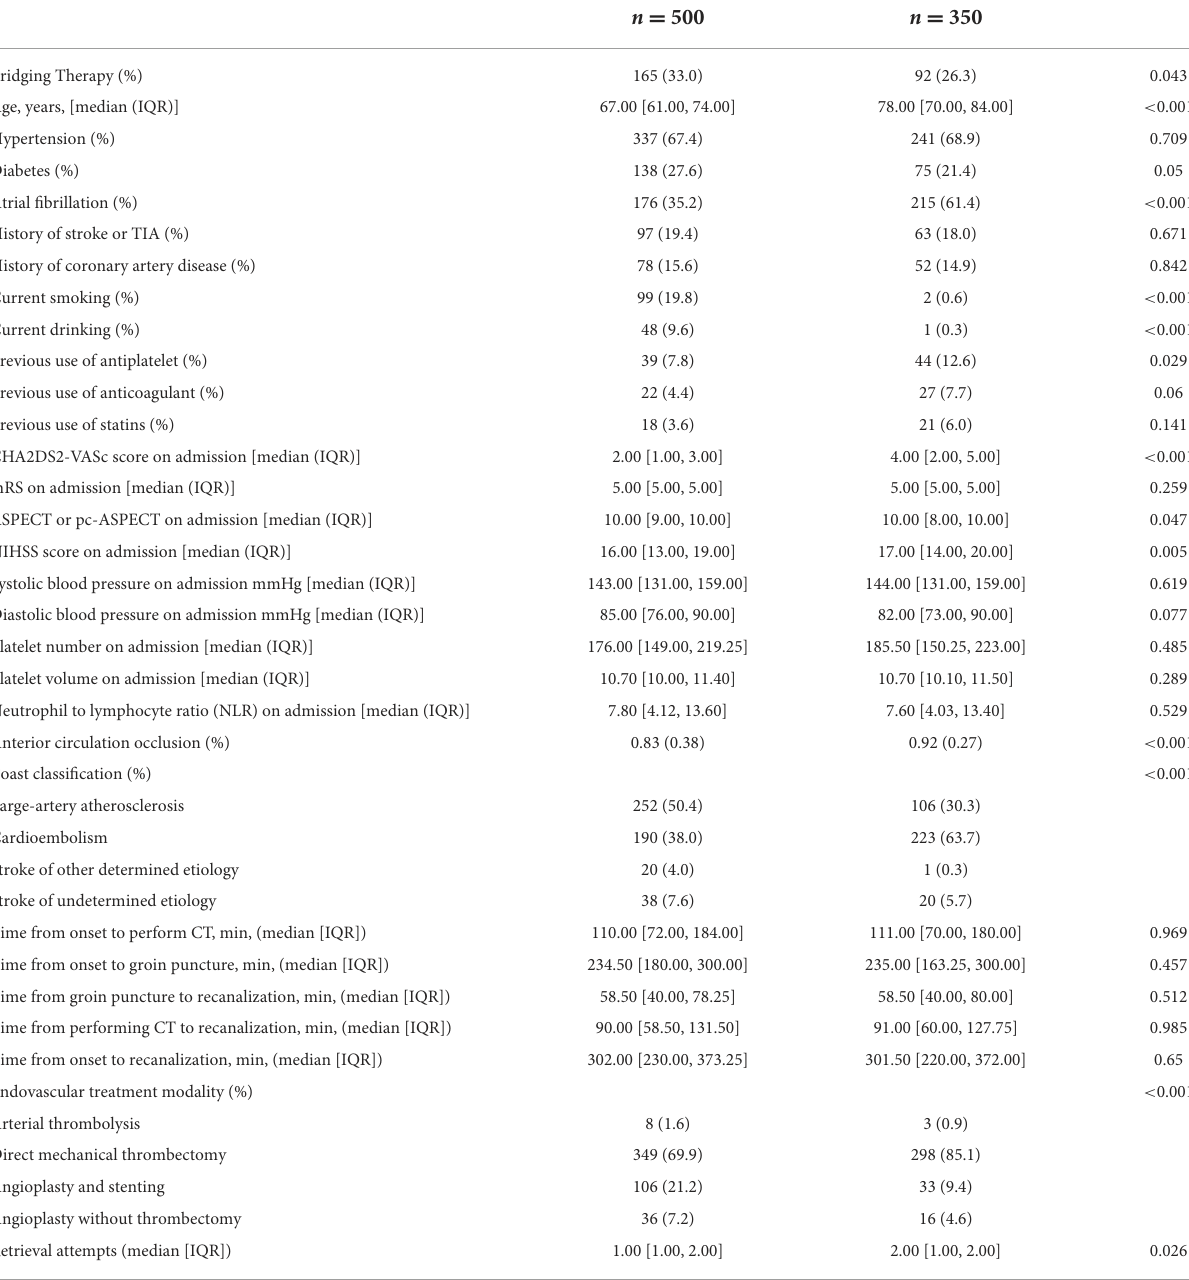
TABLE 1 Baseline characteristics of male and female